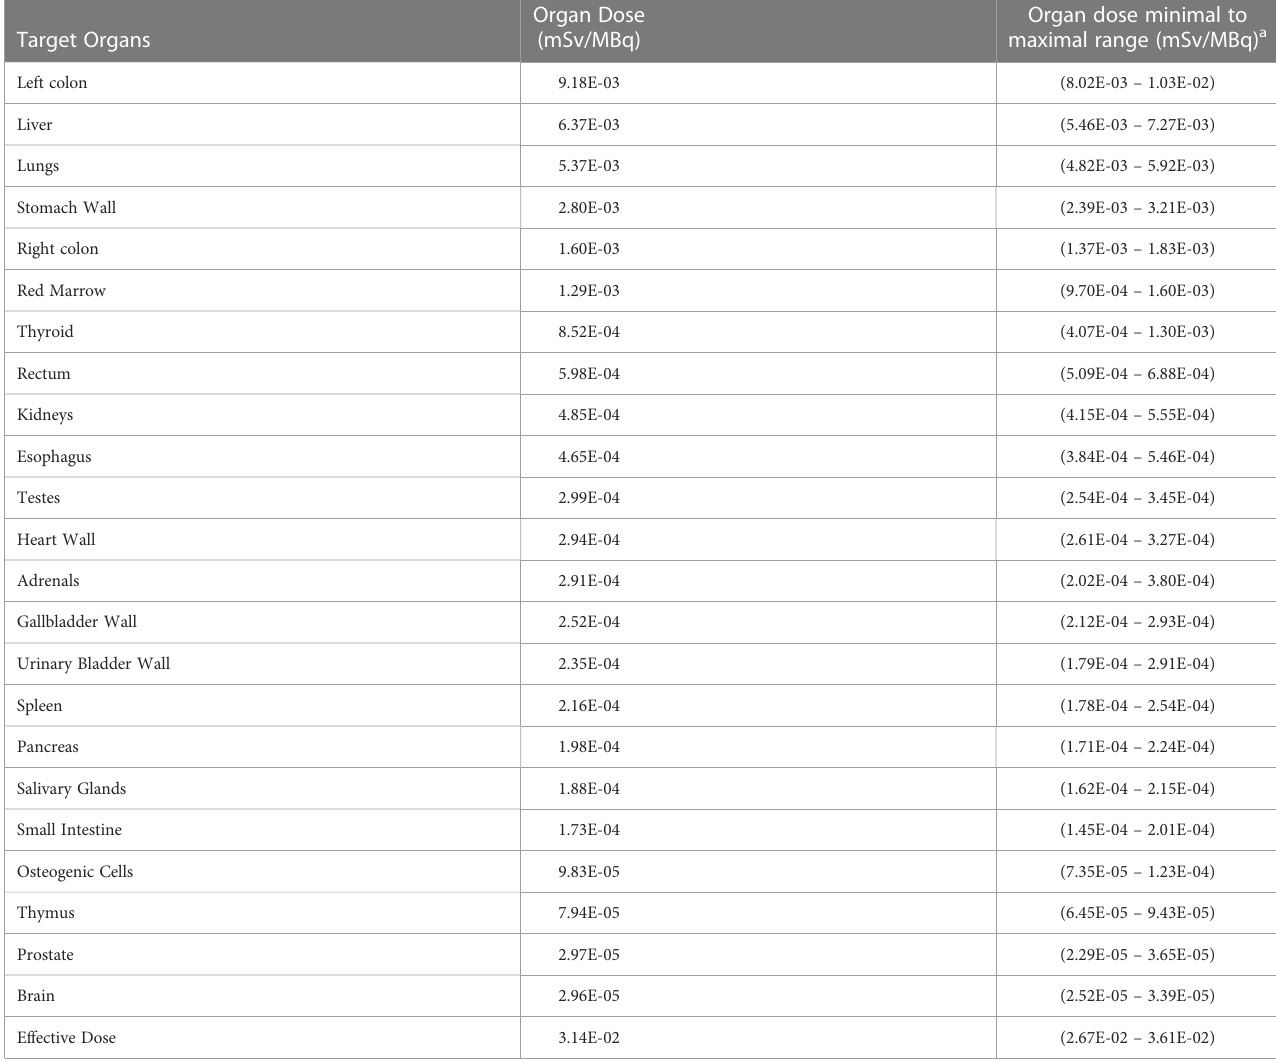
TABLE 2 Human dosimetry of 64 Cu-DOTHA 2 -PSMA extrapolated from mouse biodistribution data. Target Organs